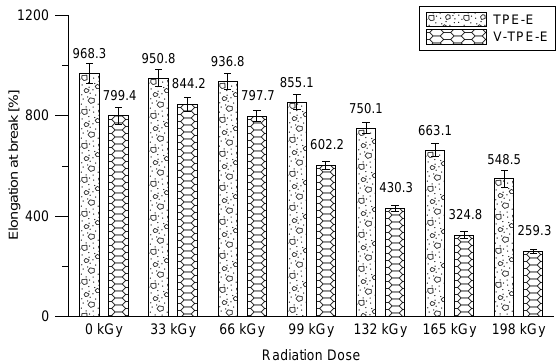
Figure 11. Elongation at break dependence on the radiation